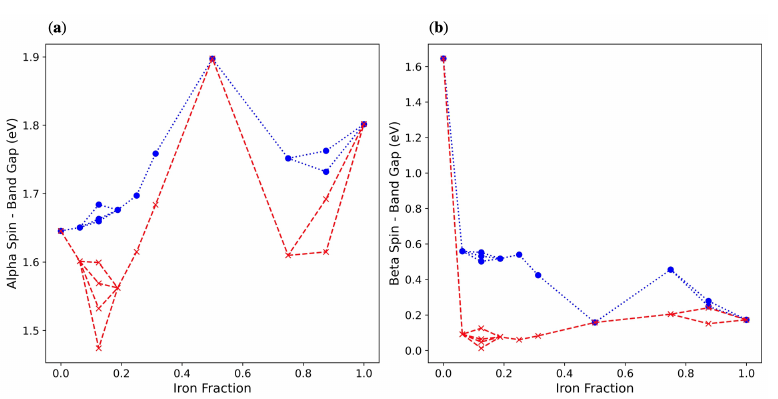
Figure A7. Band gaps for the α (blue circles) and β (red crosses) configurations in ( a ) major; and ( b ) minor spin